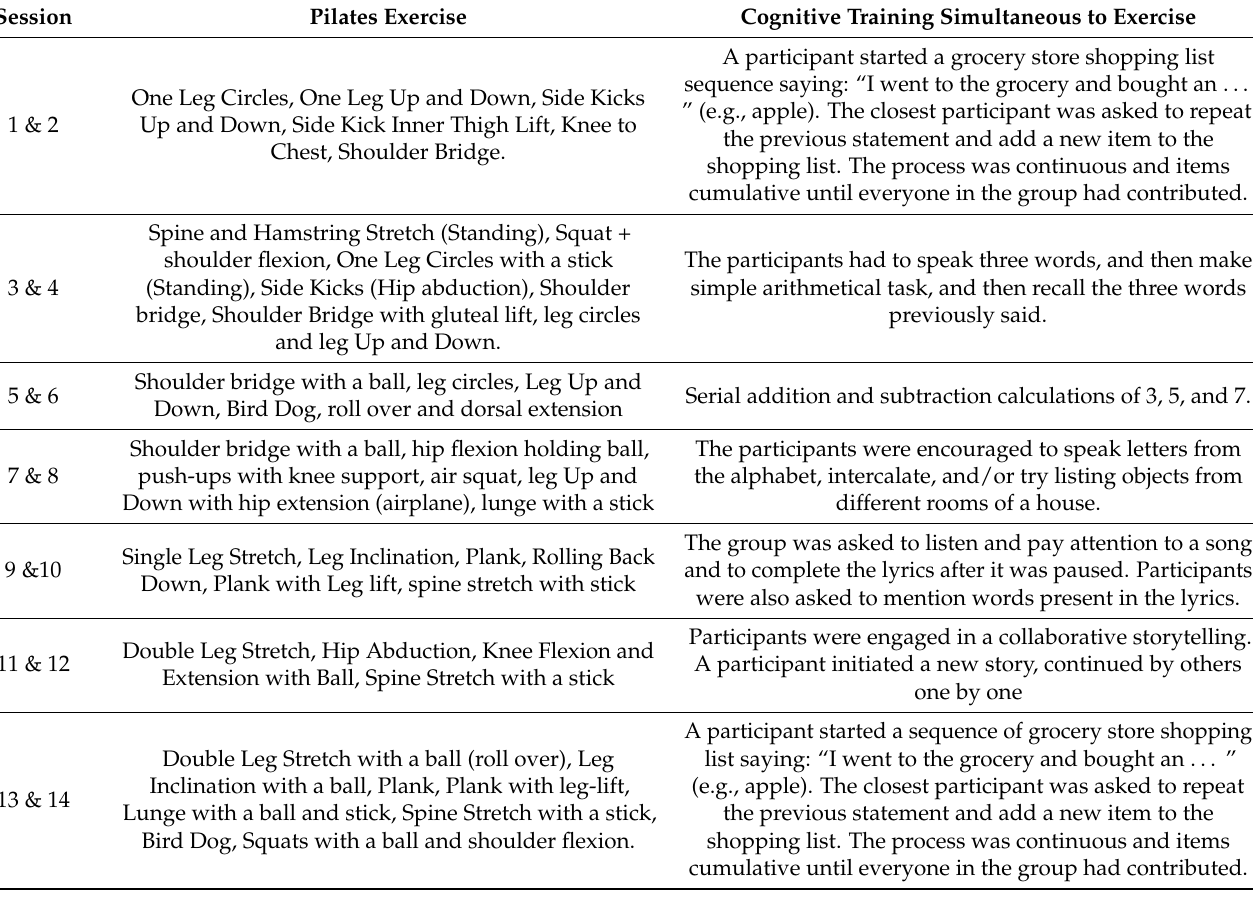
Table 1. Dual-task Intervention program